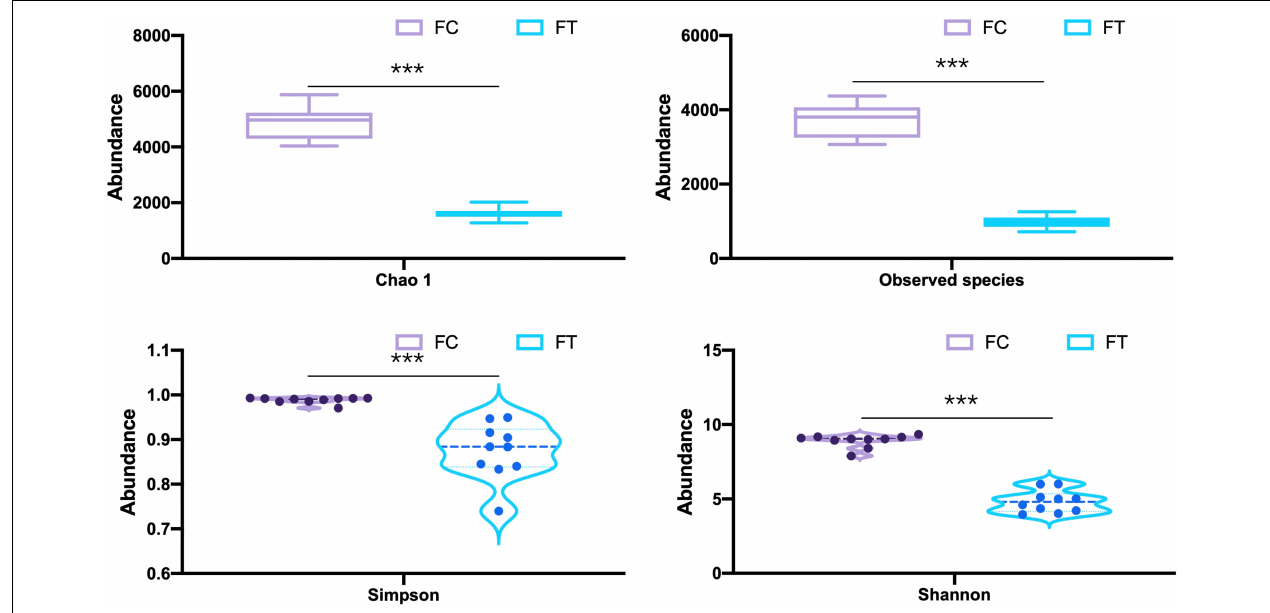
FIGURE 1 | Comparison of the α -diversity indices (Chao 1, the number of species, Shannon, and Simpson) of the control females (FC) and the antibiotic-treated females (FT). Statistical significance: ***, P < 0.001.